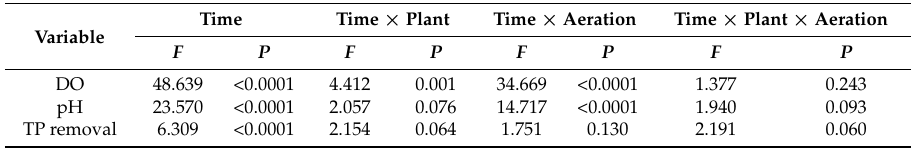
Table 2. Results of two-way repeated measures analysis of variance when Fe:P =